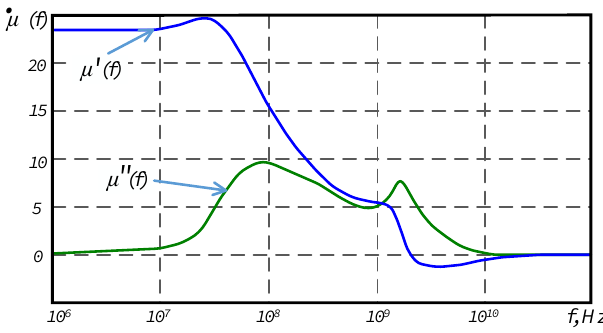
Fig. 11. CIP of NiZn ferrite [7] with DW and NSR resonances.